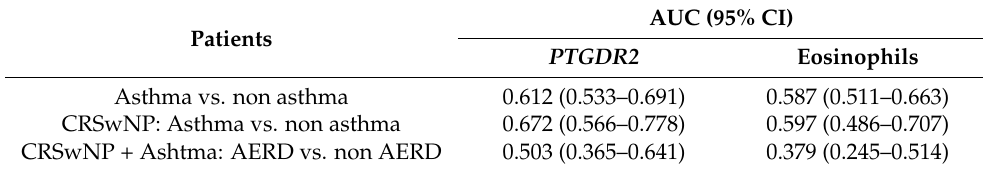
Figure 3. Scatter plot of the linear relationship of PTGDR2 expression and peripheral eosinophil counts (left panel). Comparison among asthma patients with and without polyposis, simple polyposis, allergic rhinitis, and controls are shown. (Panels A – C ) show the main groups independently. Four quadrants were obtained by dividing according to a positivity cutoff of 250 eosinophils cells/ µ L (Specificity > 95%) and a cutoff of 9.3-fold difference for PTGDR2 expression (Specificity >95%): Q1 (EO < 250 cells/ µ L; PTGDR2 < 9.4-fold); Q2 (EO < 250 cells/ µ L; PTGDR2 > 9.3-fold); Q3 (EO > 250 cells/ µ L; PTGDR2 > 94-fold); Q4 (EO > 250 cells/ µ L; PTGDR2 < 9.3-fold). Table 7. ROC curve analysis in